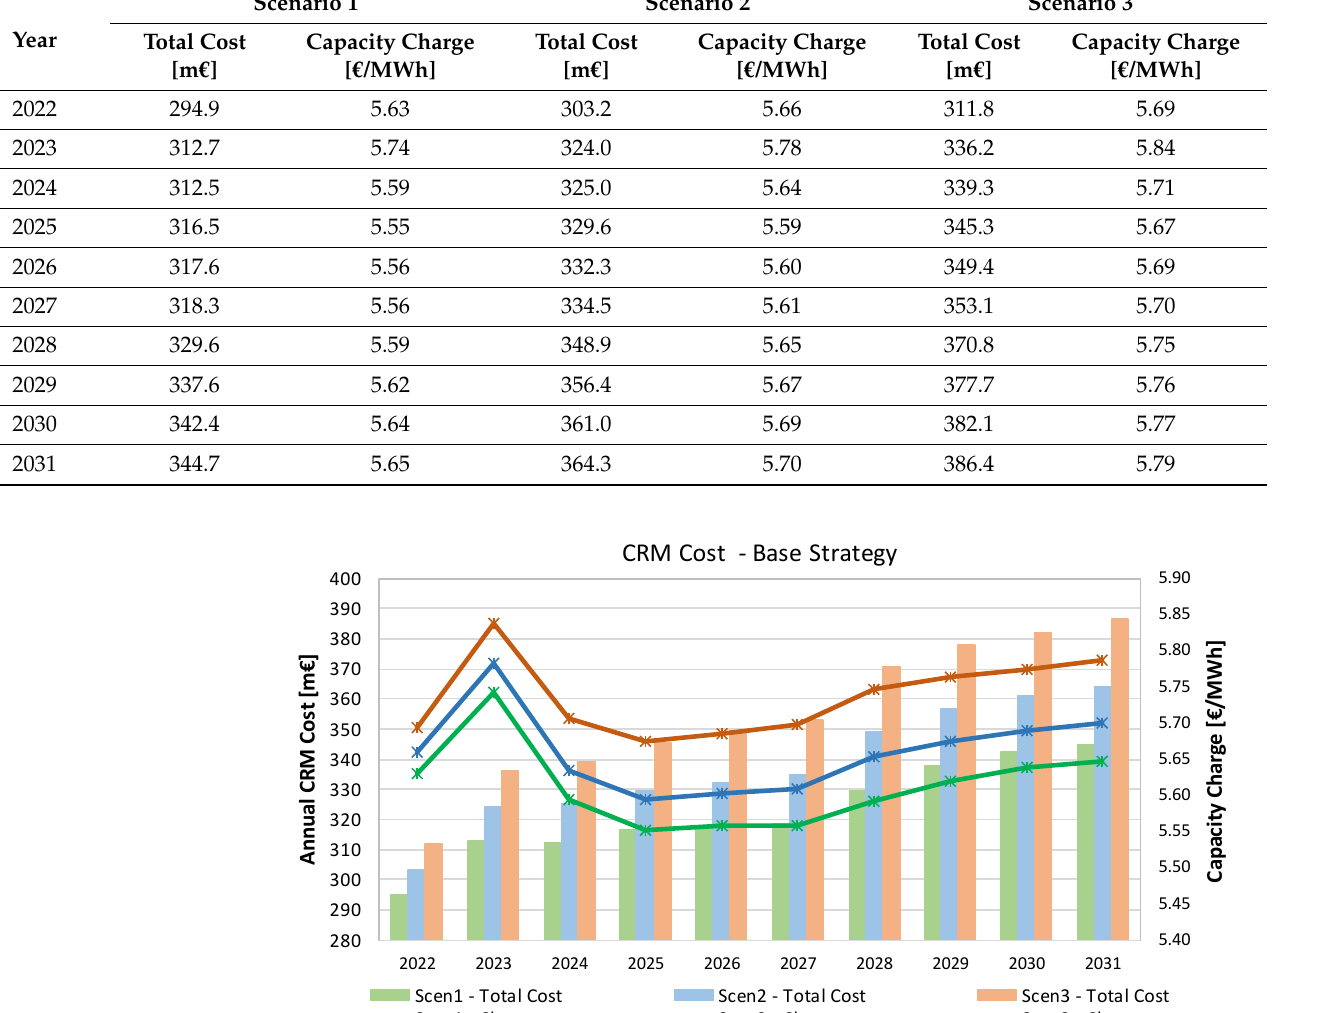
Table 4. CRM Cost–Base Strategy.